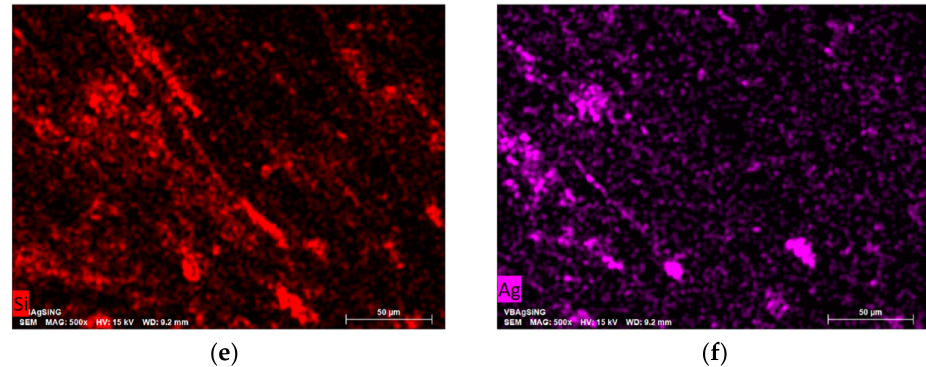
Figure 7. SEM image of the morphology of Ag NPs/HBPAPES/cotton ( a ) and the elemental distribution of O ( b ), N ( c ), C ( d ), Si ( e ) and Ag ( f ).